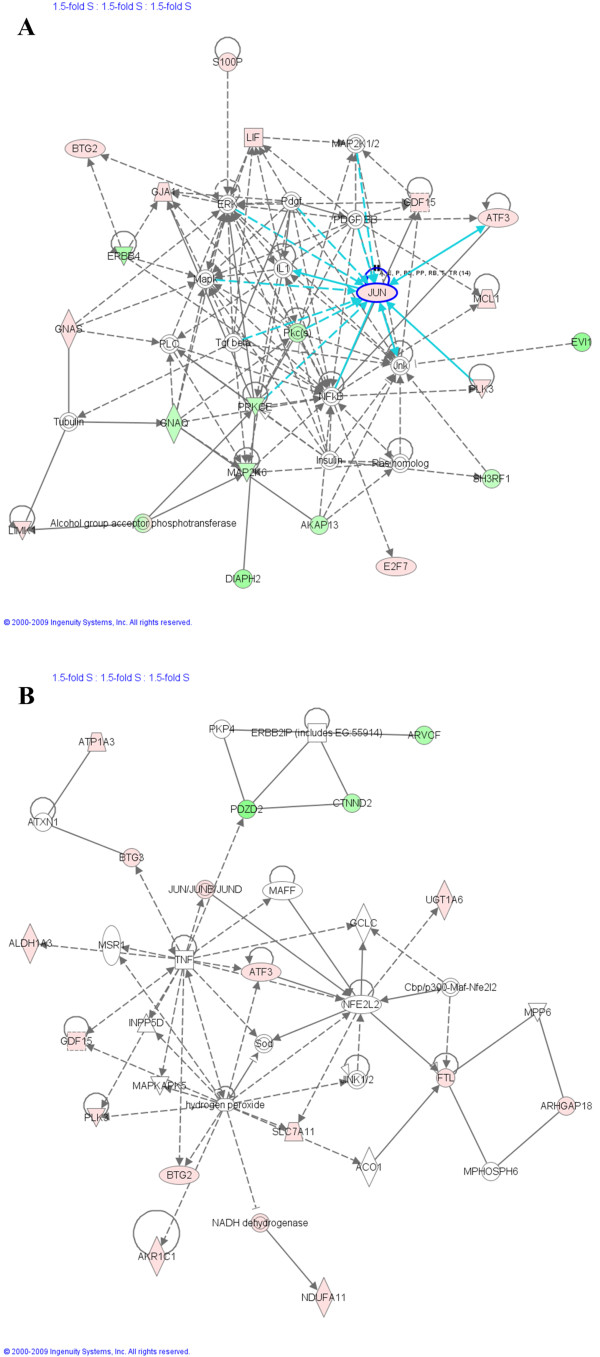
Ingenuity Pathway Analysis (IPA) on genes modulated by BaP in S-enriched MCF-7 cell cultures. Gene lists of 1.5-fold differentially expressed genes in different phases were imported to IPA software, which revealed the involvement of several pathways and genes in the response to BaP. Two networks are shown here. Red colour denotes up-regulation and green colour denotes down-regulation. The IPA legend is shown in Additional file 6.